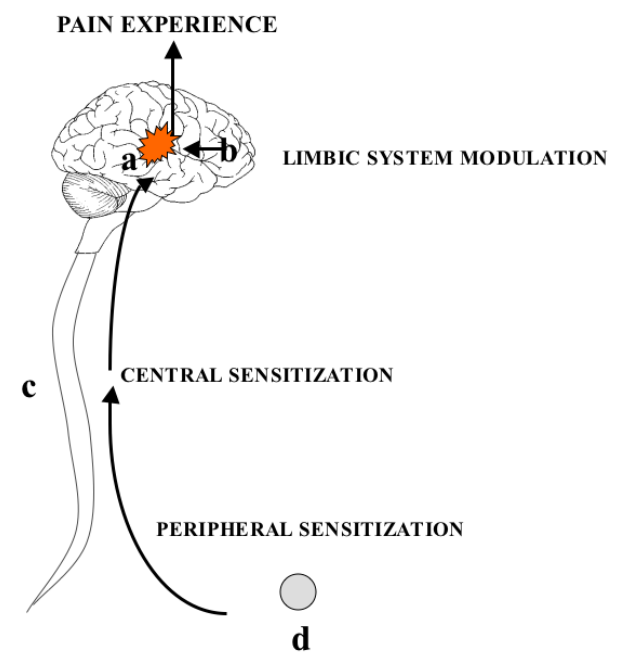
FIGURE 1. Diagram showing the pathway of pain from the peripheral receptors to cortical areas (a, secondary somatosensory area; b, limbic areas including the cingulate cortex; c, spinal cord; d, peripheral